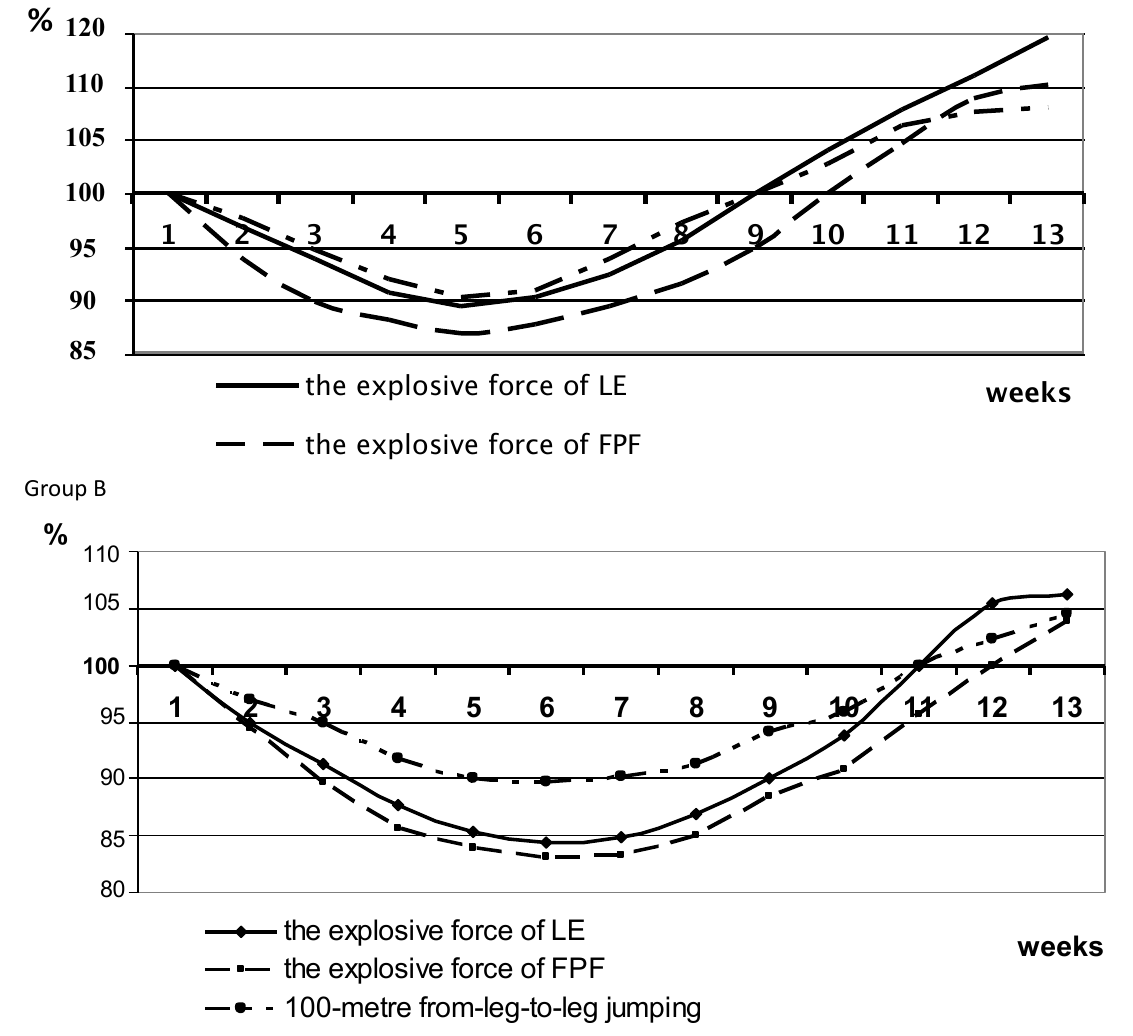
Figure 3 . Dynamics of speed-strength indicators in short-distance runners of different gender identities during the observation